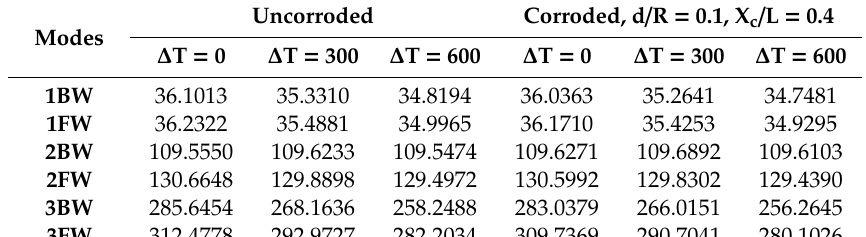
Table 6. E ff ect of ∆ T values on change in whirl frequencies due to corrosion. Table 6. Effect of Δ T values on change in whirl frequencies due to corrosion.